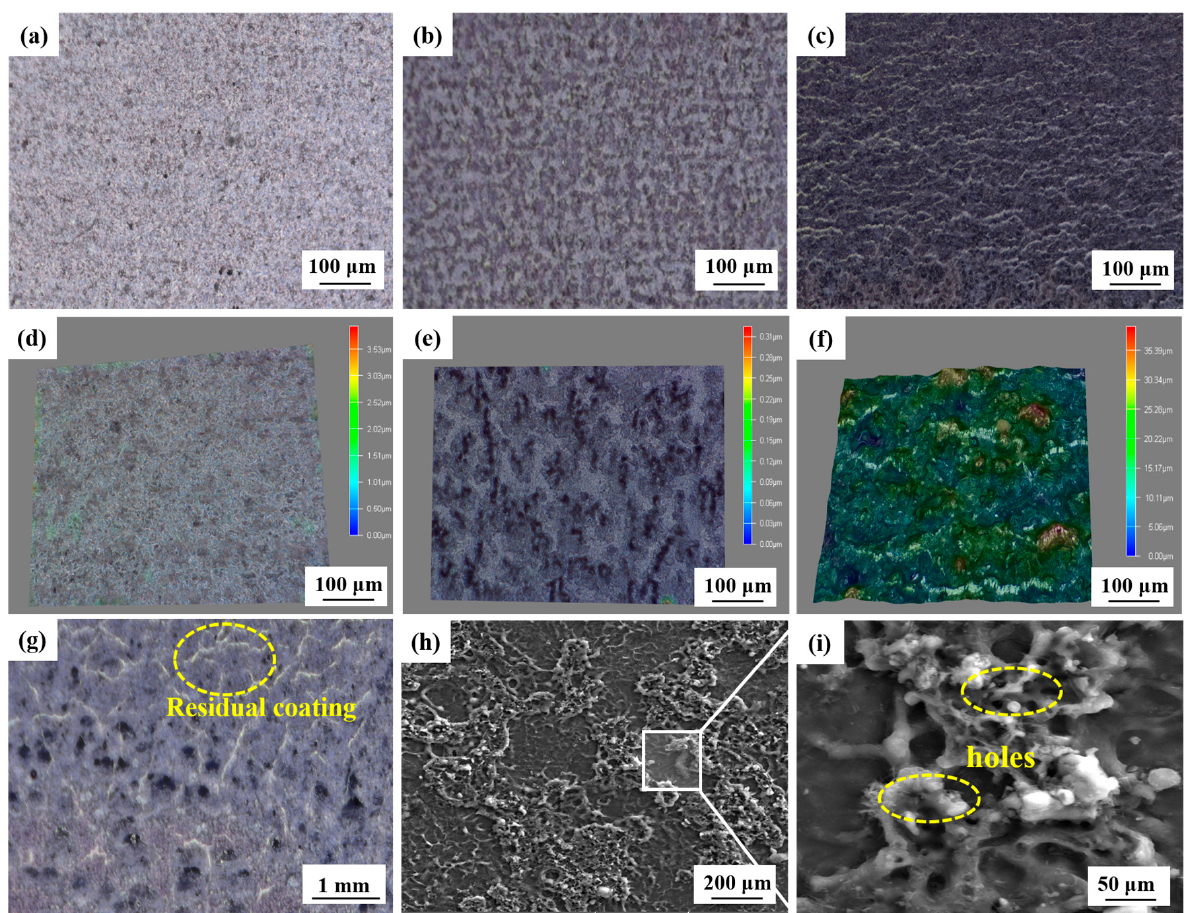
Figure 8. Surface microscopic and three-dimension optical images of the specimens after laser removal with ( a , d ) N-1 (12 J/cm 2 , 87.4%), ( b , e ) Y-1 (14.5 J/cm 2 , 87.6%) and ( c , f , g ) Y-2 (7 J/cm 2 , 96.5%), ( h , i ) microscopic images of regenerated Al 2 O 3 from Y-1 specimen.